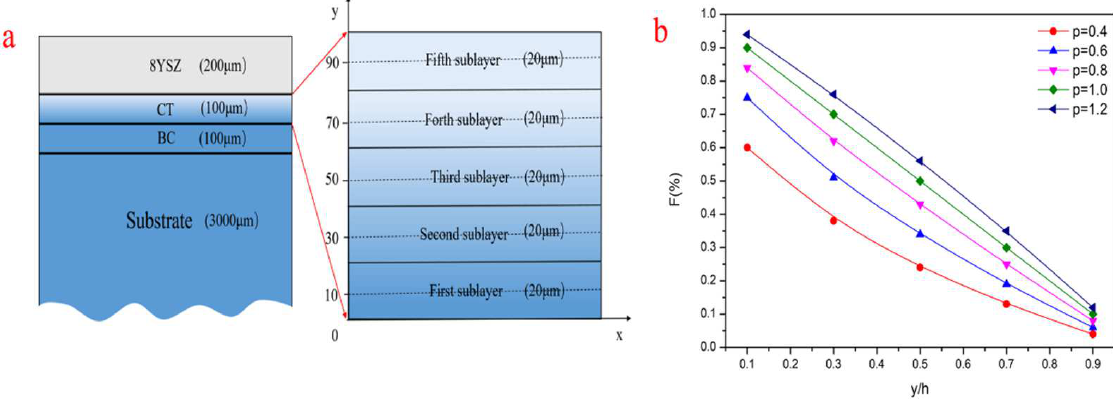
Figure 1. Schematic diagram of continuous transition coating structure ( a ), volume fraction of metal in each sub-coating under different gradient indices in the continuous transition zone ( b ).